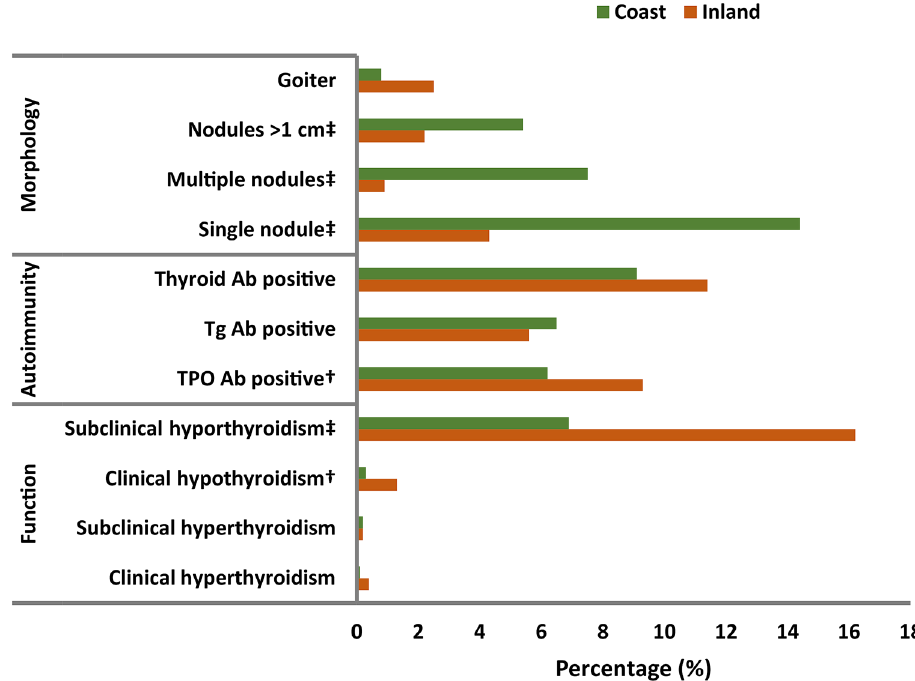
Figure 1. Spectrum of thyroid abnormalities by region. The bar chart showed the difference in incidence of each sort of thyroid abnormalities between the coast and the inland via Chi-square tests (†: p < 0.05; ‡: p < 0.001).